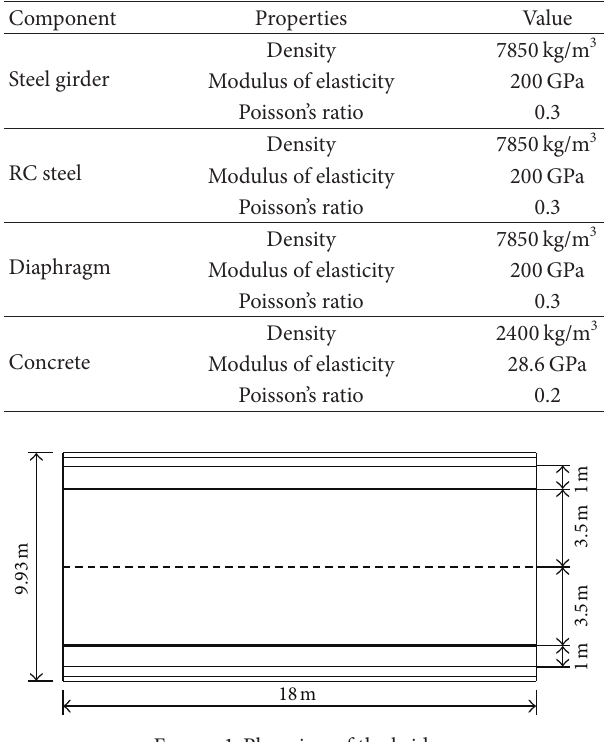
Figure 1: Plan view of the